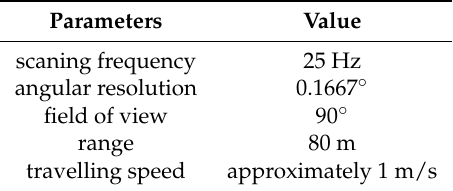
…… Figure 6. An instance of single-scale feature extraction with the region size threshold ε . Symbols formatted as P t , C ε , U ε , and s ε are depicted in Section 3.2. At the beginning of the iterative t t , n t , n process of point partitioning, C ε is initialized as ∅ . Then, regions and region-to-region relationships 0 are produced by the iterative point partitioning algorithm (IPPA). The region-to-region relationships (cid:16) (cid:17) U ε are informed by the superscript n of the region data, which are formatted as . Note that , s ε t , n t , n (cid:17) (cid:16) = ∅ , s ε U ε the regions without points (e.g., region data ) are discarded for feature extraction. t , a t , a Based on the region-to-region relationships, region data are reorganized in sequences (e.g., sequence (cid:16) (cid:16) (cid:17) (cid:16) (cid:17) (cid:17) U ε U ε . . . , , , . . . ). SFNs extract and fuse features among the sequential , s ε , s ε t − 1, a t − 1, a t + 1, a t + 1, a region data to acquire the point features with 3D contexts. We share the weights of SFNs for processing (cid:110) (cid:111) = f p ε data at a single scale. The output Fp ε is the set of point features corresponding to , . . . , f p ε t t ,1 t , N t } . the input points P t = { p t ,1 , . . . , p t , N t Table 1. Parameters of our MLS